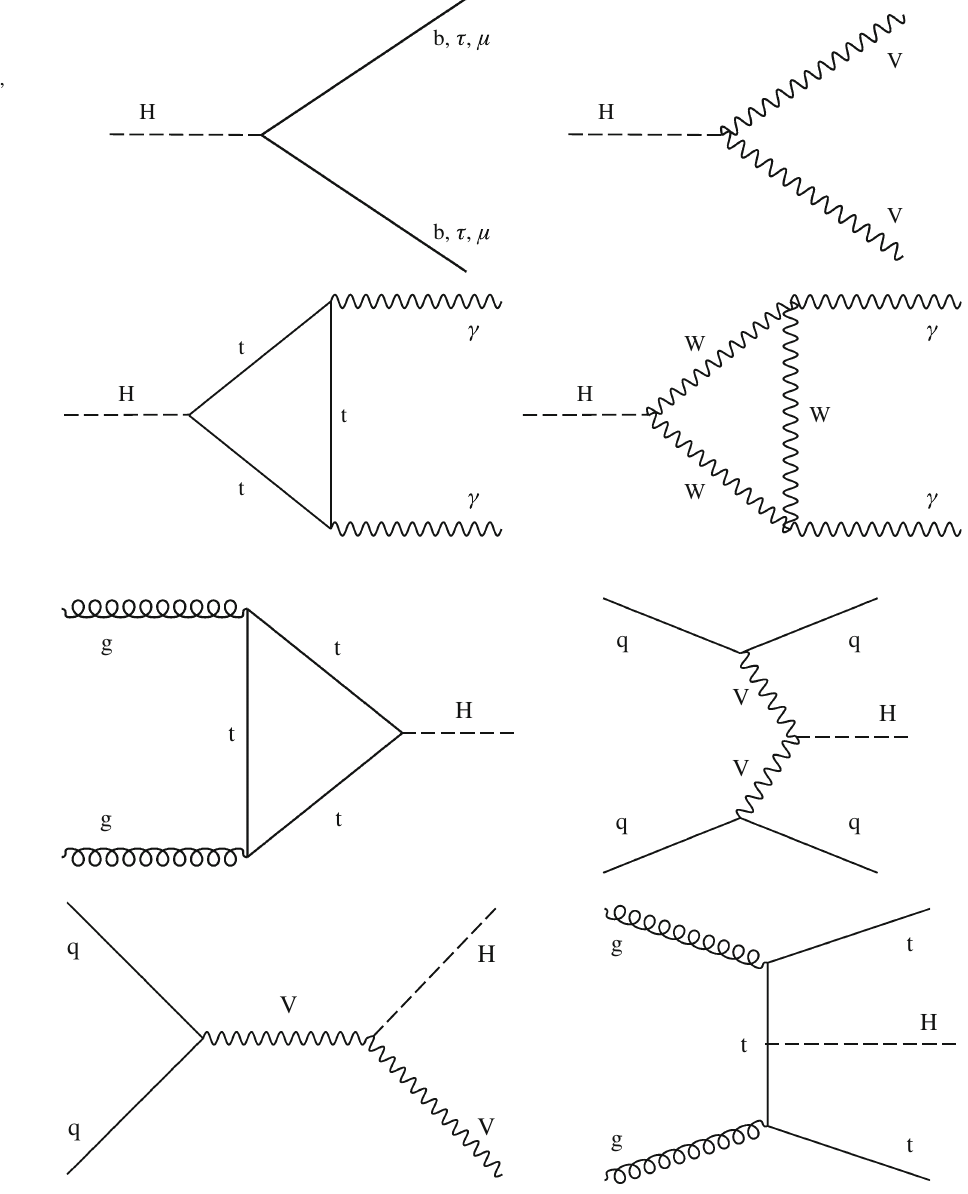
Fig. 1 Examples of leading-order Feynman diagrams for Higgs boson decays in the H → bb, H → ττ ,